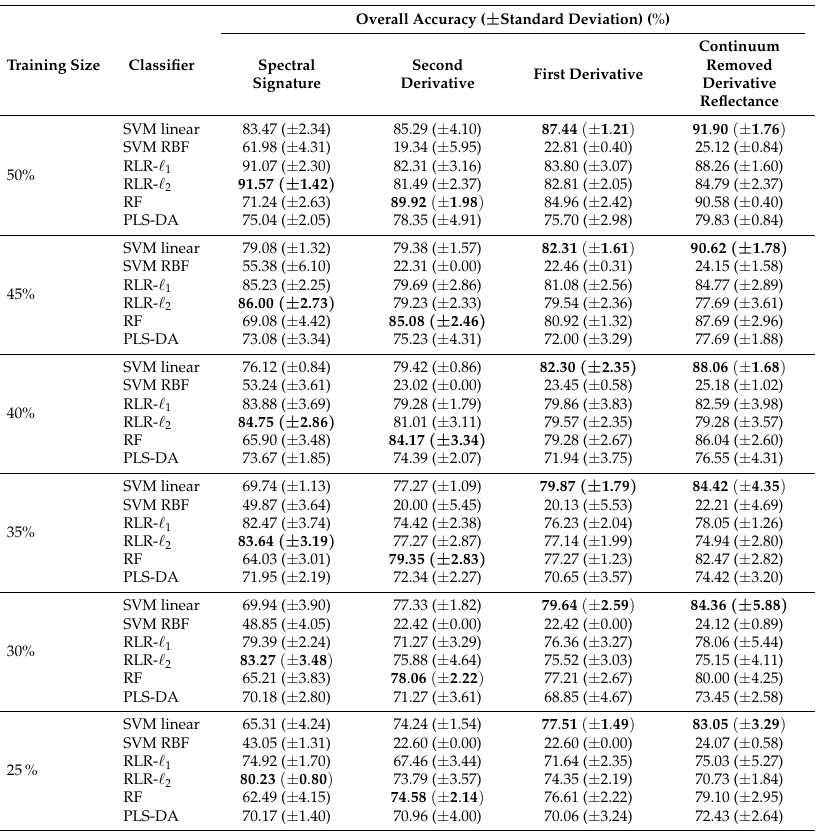
Table 20. Vegetation types identification accuracies (overall accuracy ( ± standard deviation) in %) on [350–2500 nm].